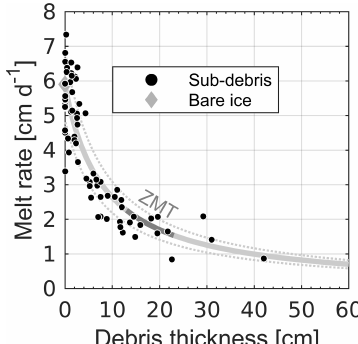
Figure 6. Sub-debris melt rate measurements. Melt rate as it varies with debris thickness. Sub-debris melt rates are corrected for the different measurement periods (see Sect. S1.1). The solid line is the curve fit using the hyper-fit model for the best debris thickness–melt relationship (RMSE of the data is 0.8cmd − 1 ). The portion of the best curve fit in the zone of maximum thinning (ZMT) is shaded darker than the rest of the line. The dotted lines represent the ± 1 σ error bounds used in the uncertainty estimates of distributed melt.